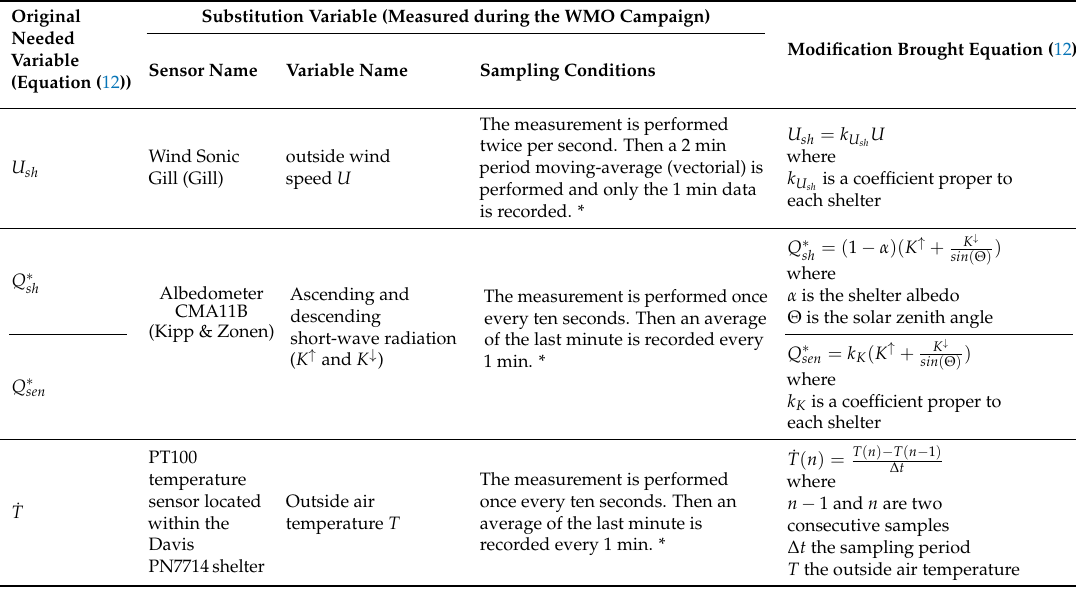
Table 3. Description of the replacement of variables originally needed in Equation